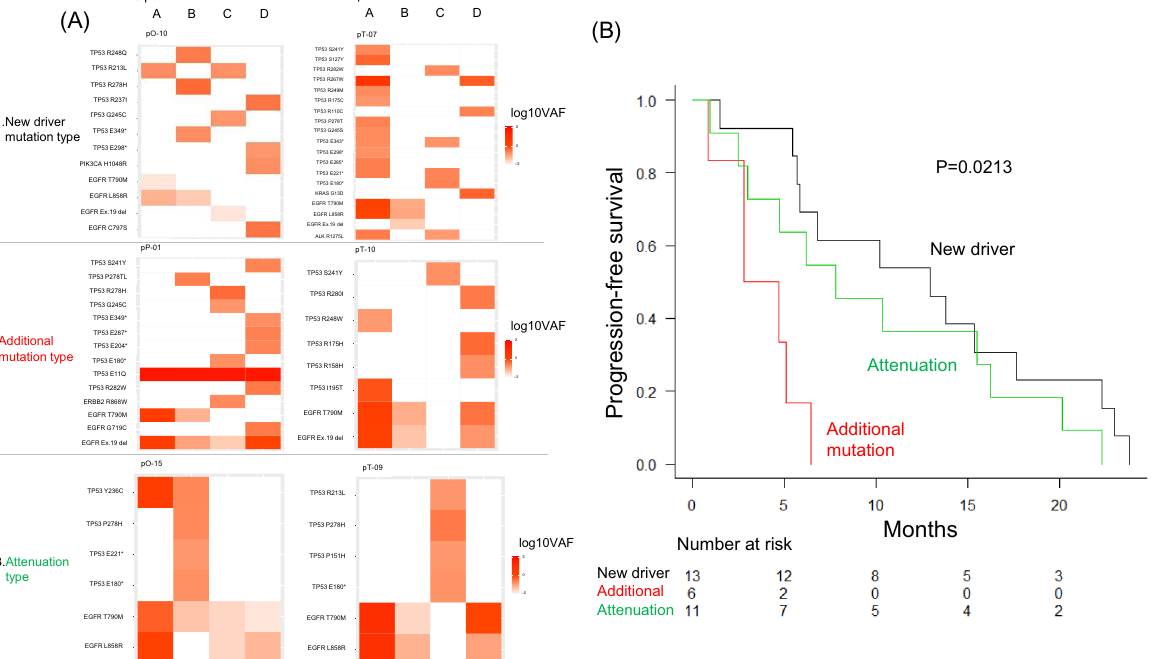
Figure 3. ( A ) Representative heat maps of clonal evolution types (new driver mutation type, additional mutation type, and attenuation type). The Y axis represents each mutation, and the X axis represents VAF from point A to D. The percentage of VAF is expressed in alongside heat map tones. In the new driver mutation type, EGFR mutation disappears and a new driver mutation appears in point D. In the additional mutation type, additional driver mutations appear in addition to EGFR mutation. In the attenuation pattern, driver mutation only of EGFR mutation is confirmed even in point D. ( B ) Kaplan–Meier plot of PFS for osimertinib treatment. Comparison of PFS between the new driver mutation type, additional mutation type, and attenuation type ( p < 0.05).